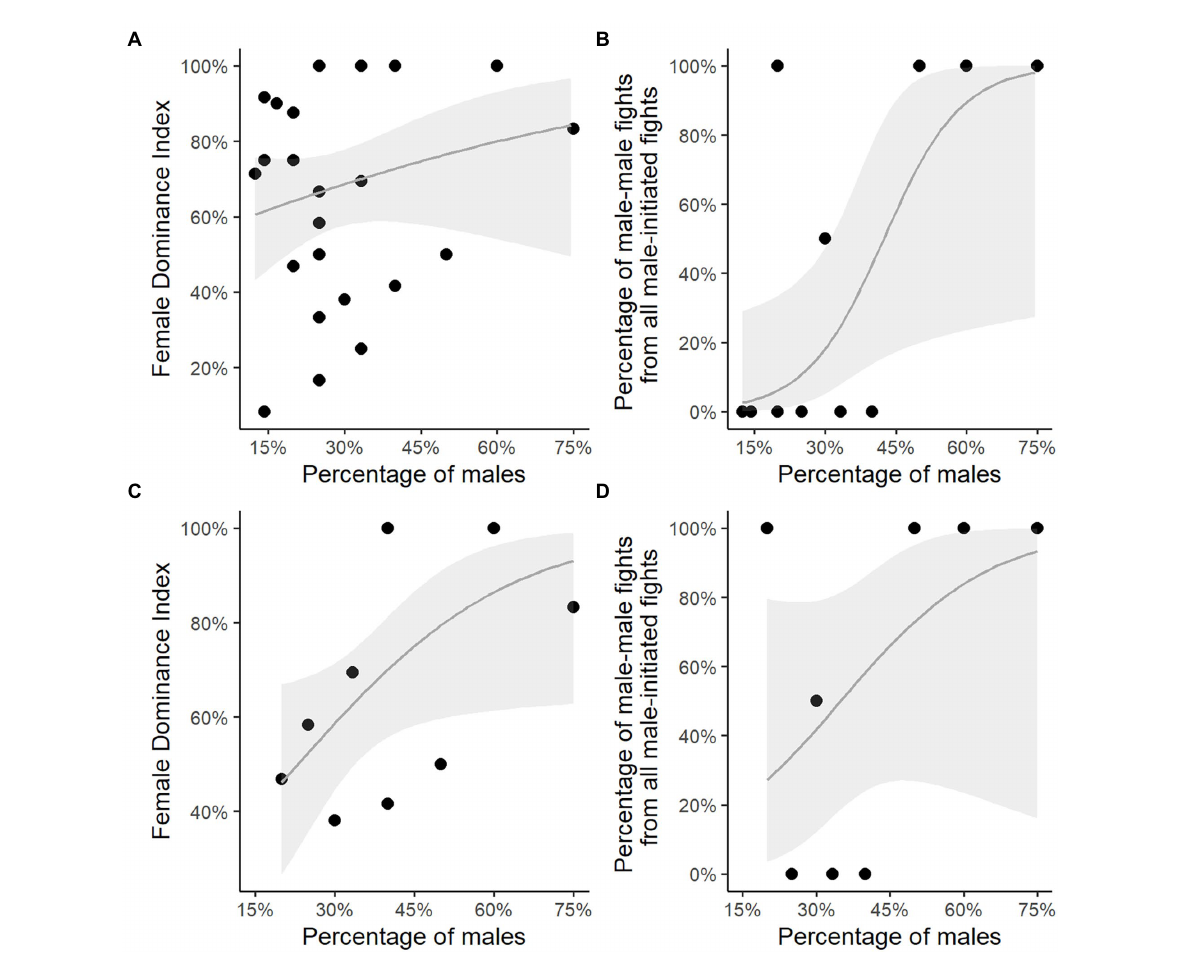
FIGURE 2 Percentage of resident males in rock hyrax groups versus the Female Dominance Index and the percentage of male–male fights. Percentage of resident males in groups with a single male or multiple males versus (A) the Female Dominance Index; (B) the percentage of male–male fights of male-all fights. Percentage of resident males in multi-male groups only versus (C) the Female Dominance Index; (D) the percentage of male–male fights of male-all fights. The grey line represents the fitted regression line, grey polygons represent the 95% confidence